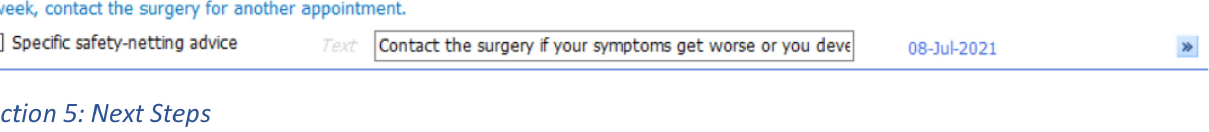
Figure 9. Summary report EMIS template – safety netting section (4).